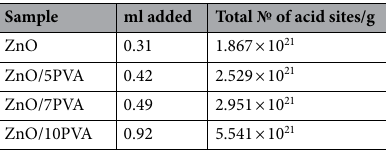
Table 1. PVA content, Volume of n-butyl amine/g and total number of acid sites/g.